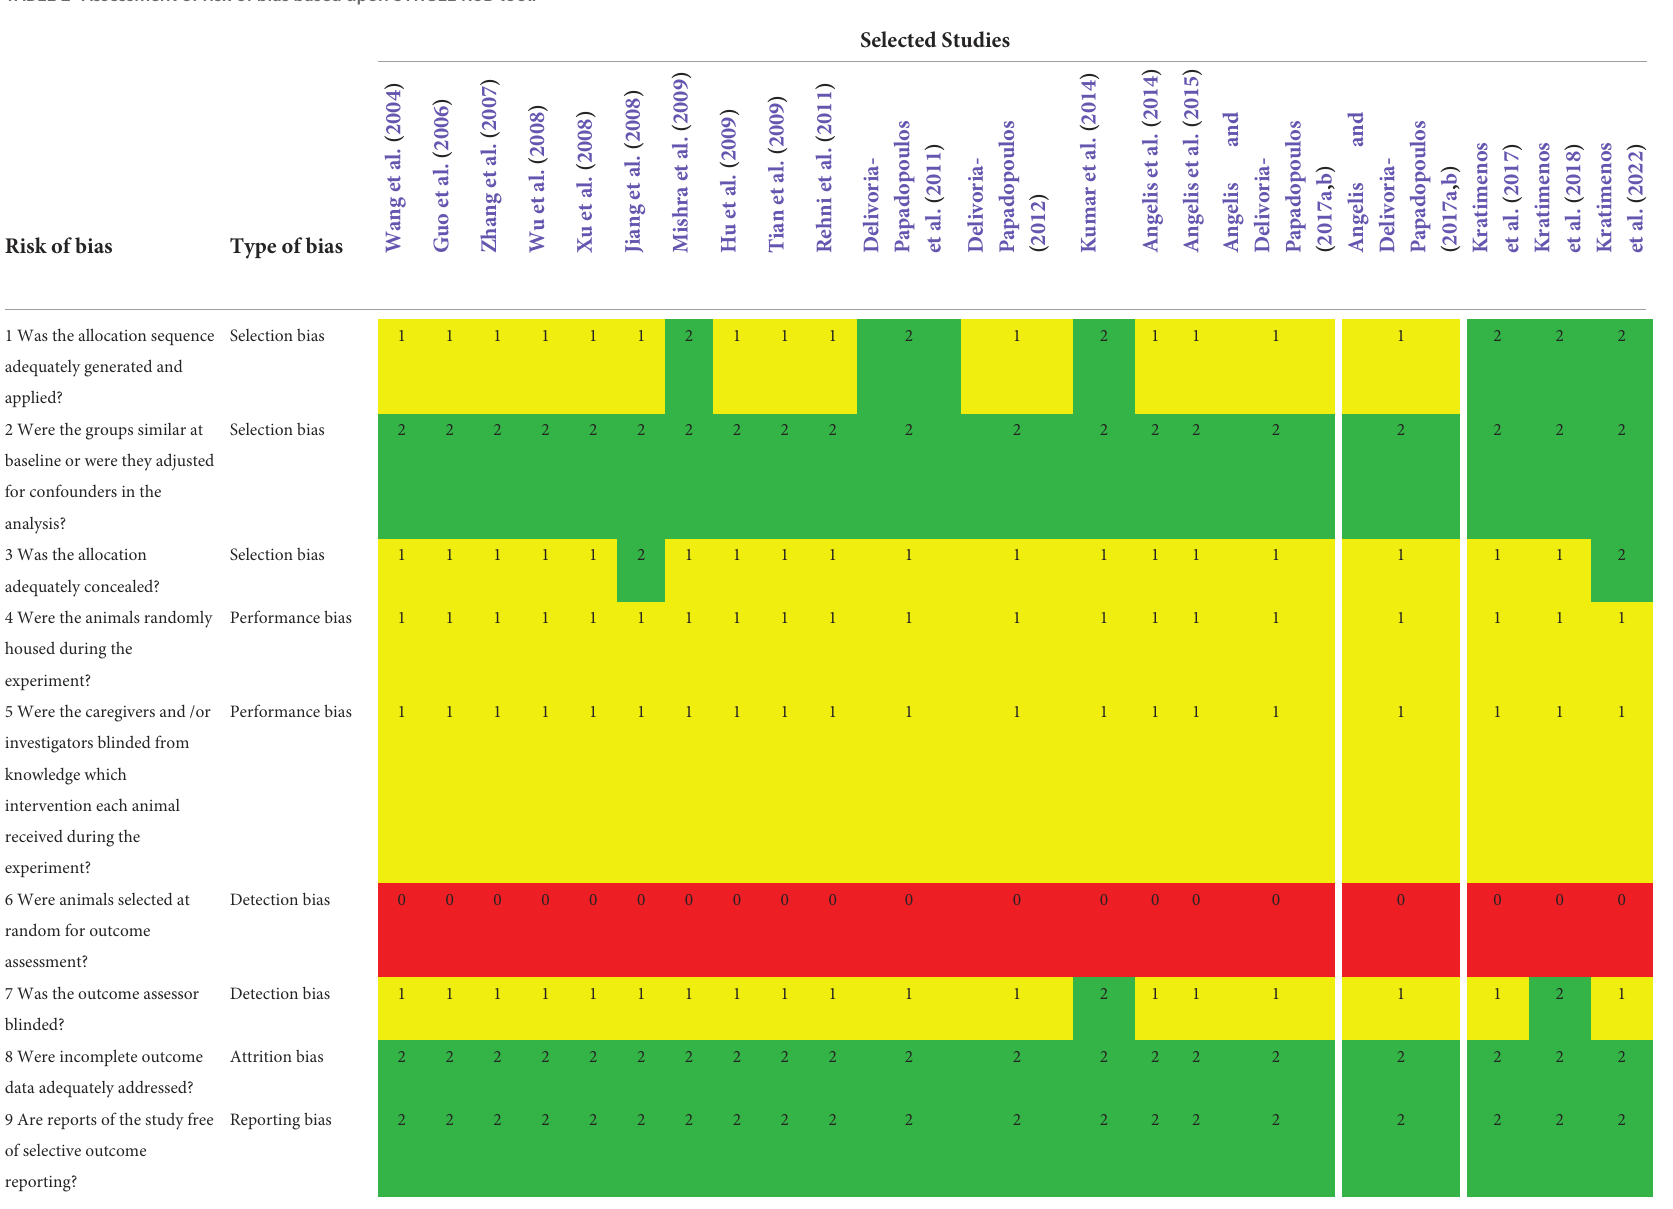
TABLE 2 Assessment of risk of bias based upon SYRCLE RoB